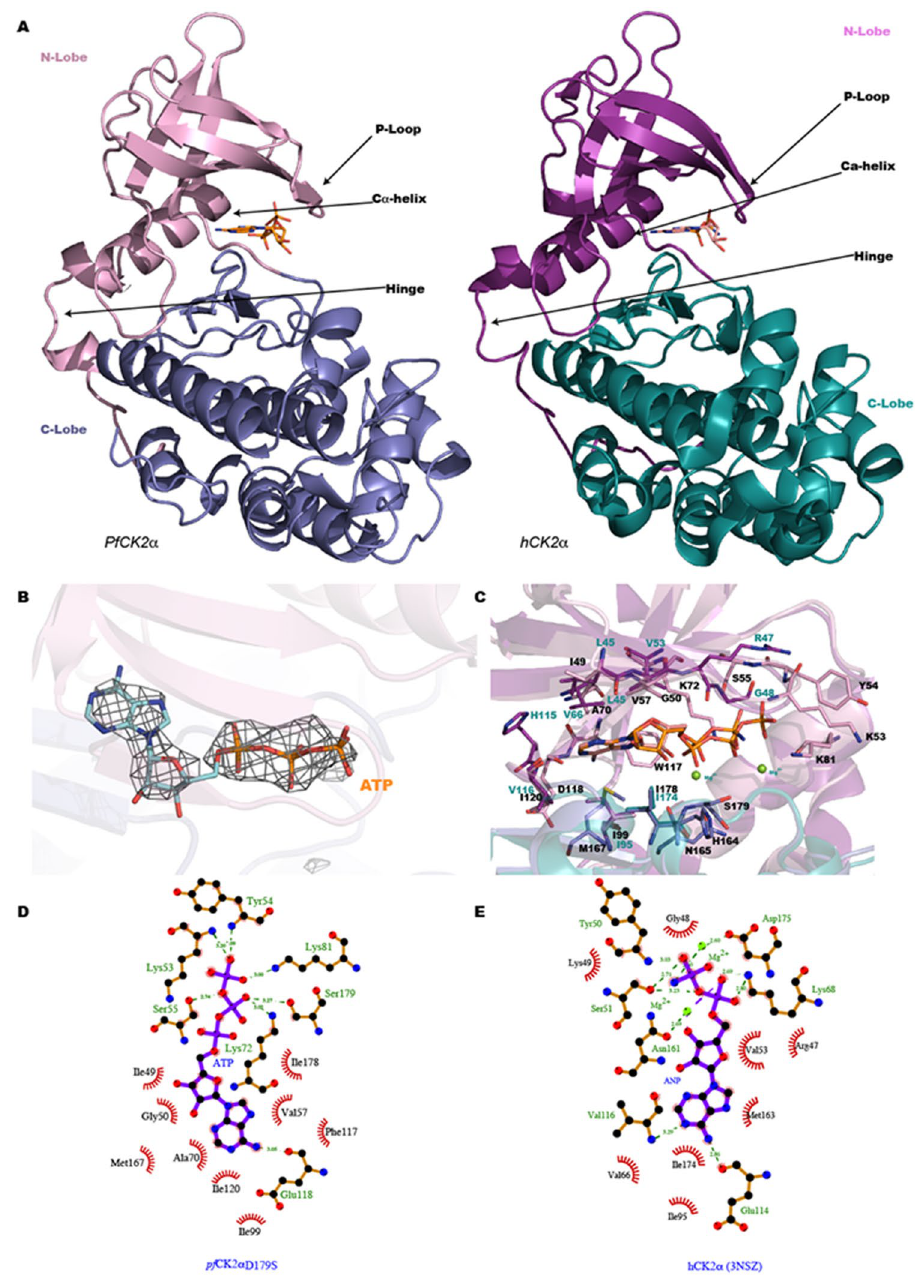
Figure 5. ( A ) Side-by side representation of the Pf Ck2 α D179S structure (left and hCK2 (right) shown in the same orientation. The N-terminal tail, the N-lobe and C lobe are displayed in different colors. Structural elements discussed in this paper, namely P-loop, hinge region and C-helix are indicated. The ATP ( Pf CK2) and AMPPNP (hCK2) ligands bound in the active site are displayed as sticks. ( B ) Close up view of the bound ATP (sticks) in the Pf CK2 active site with an omit residual electron density map superimposed. ( C ) Superposition of how the substrate is bound by the PfCK2 α D179S and human enzyme: residues contributing to the active site of Pf Ck2 α D179S are displayed using the same color code as in panel A. The hCK2-AMPPNP structure (from PDB code: 2PVR) is shown in blue. ATP and AMPPNP substrates are shown as sticks and Mg ions as green spheres (from PDB code: 2PVR). Residues are labelled in black for Pf Ck2 α D179S and in blue for hCK2. ( D , E ) Flat representation of the atomic interactions (generated with Ligplot 45 ) between PfCK2 α D179S and ATP (panel D, this work) and hCK2 (PDB code: 2PVR) and AMPPNP (panel